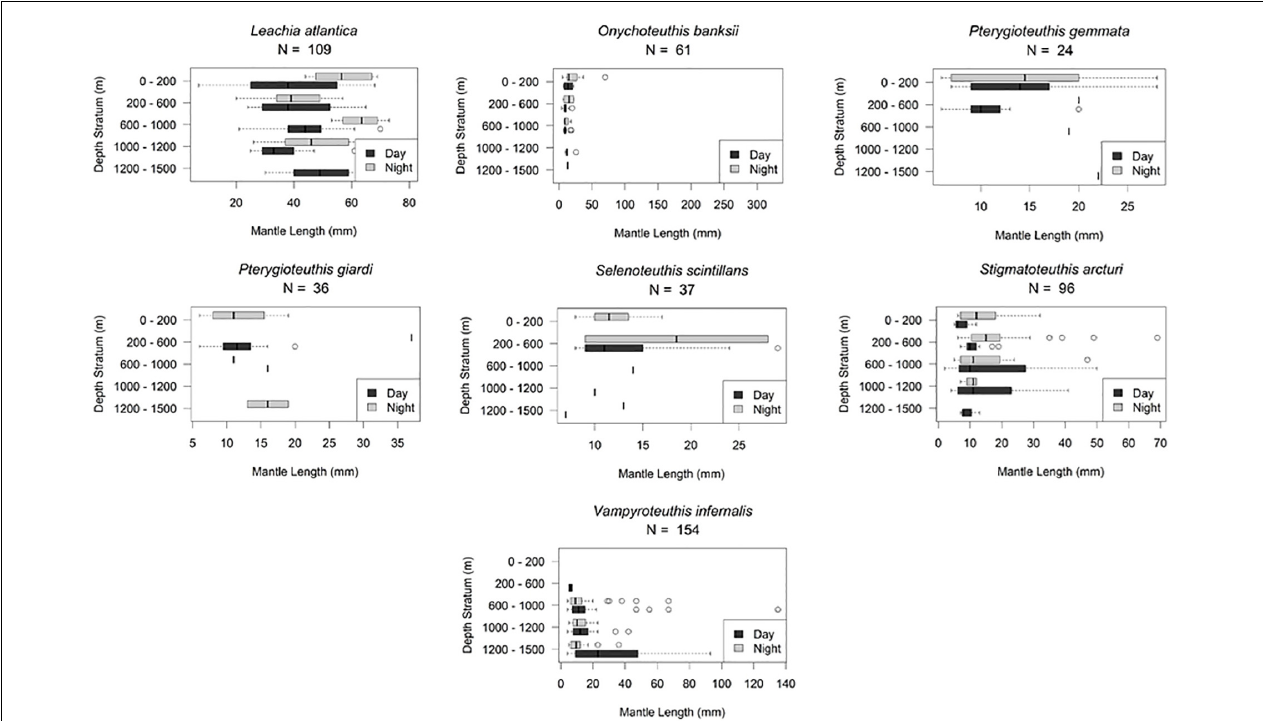
FIGURE 10 | Cephalopods displaying an ontogenic shift from deeper zones to shallow zones as they develop. Horizontal line, median; box limits, 1st and 3rd quartiles; circles, outliers.